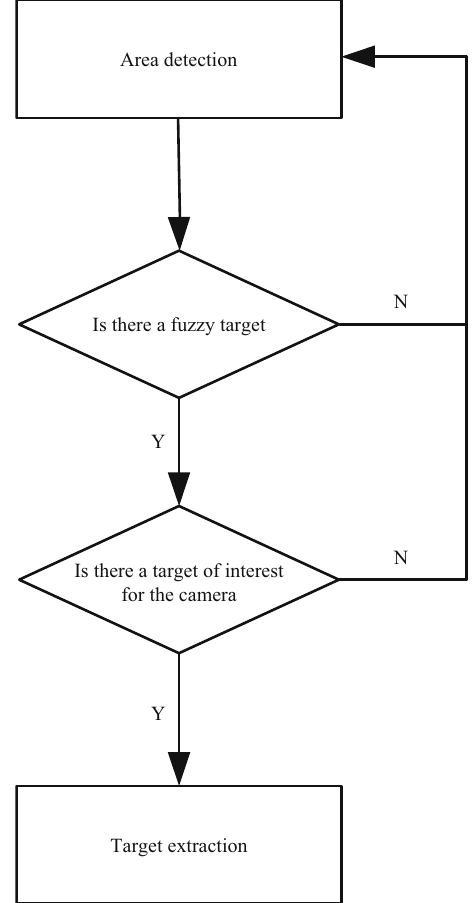
Figure 1: Edge detail feature extraction process of dynamic